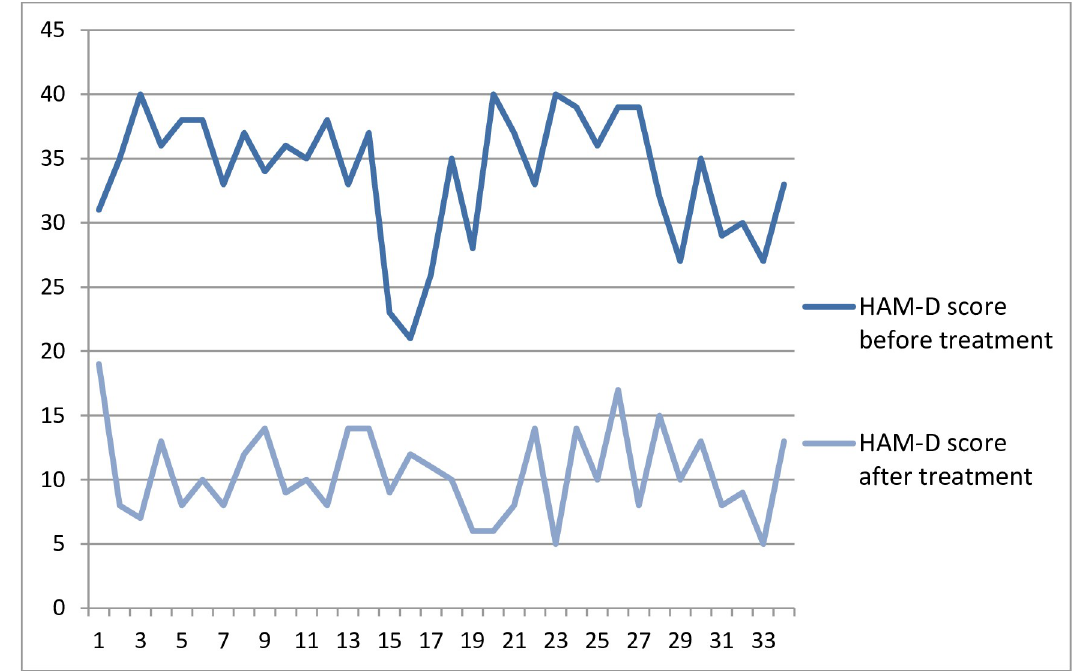
Fig 1. Hamilton depression rating scale (HAM-D) total score before and after antidepressant treatment among study participants in Jimma medical center psychiatric clinic, 2019.